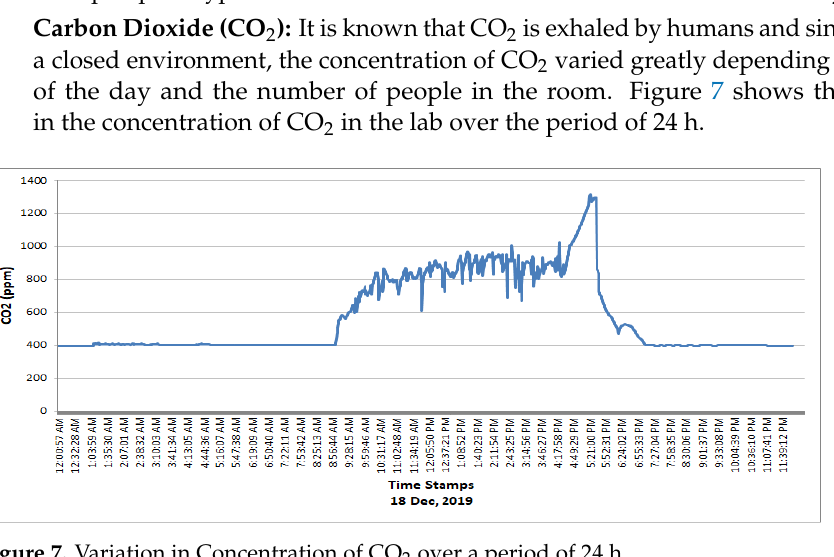
Figure 7. Variation in Concentration of CO 2 over a period of 24